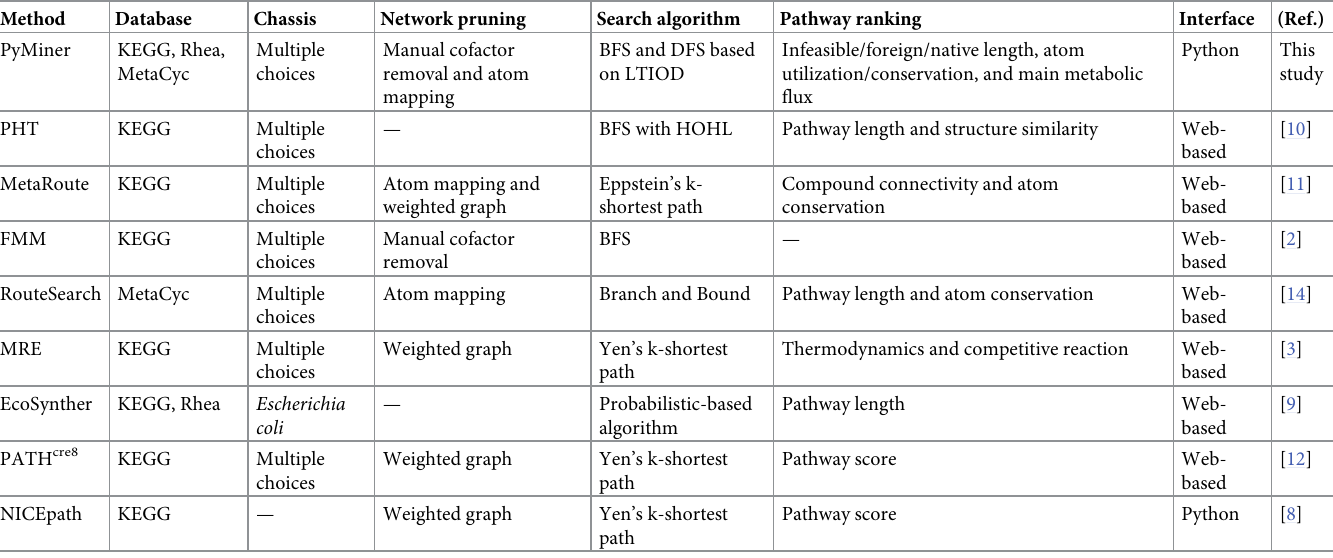
Table 1. Summary of metabolic pathway design methods and corresponding